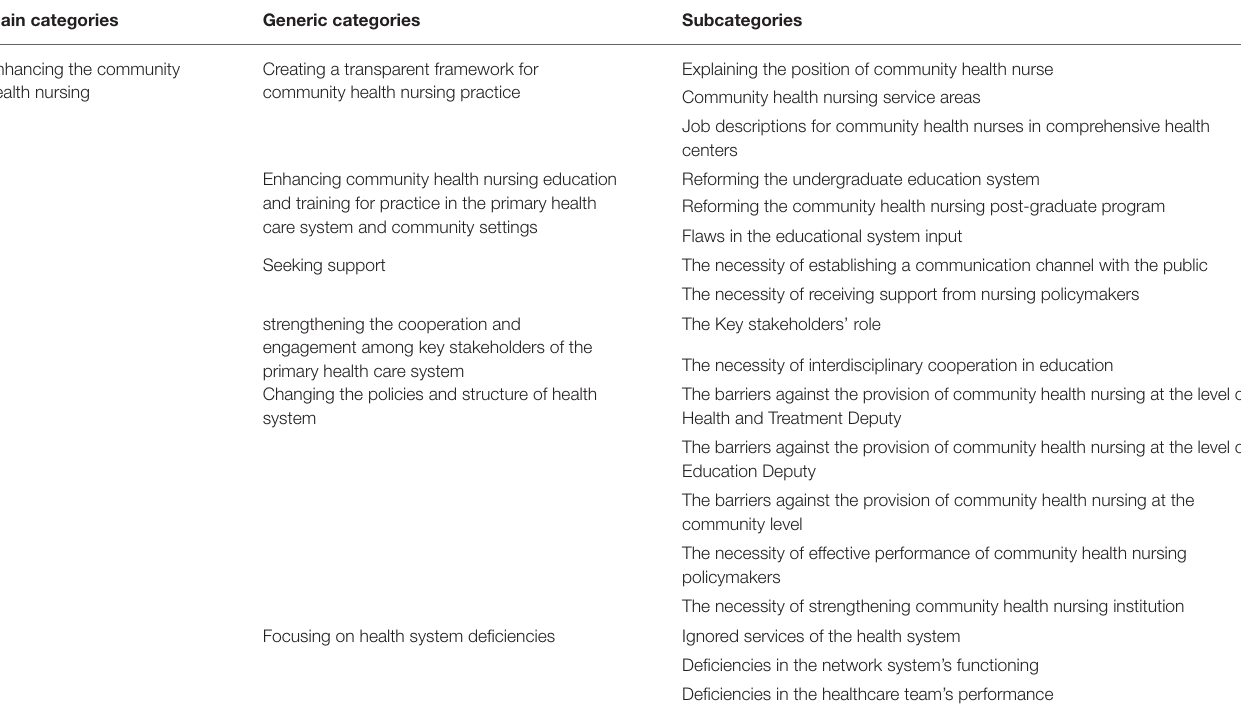
TABLE 4 | Main categories, generic categories, and sub-categories extracted from the content-driven analysis of the